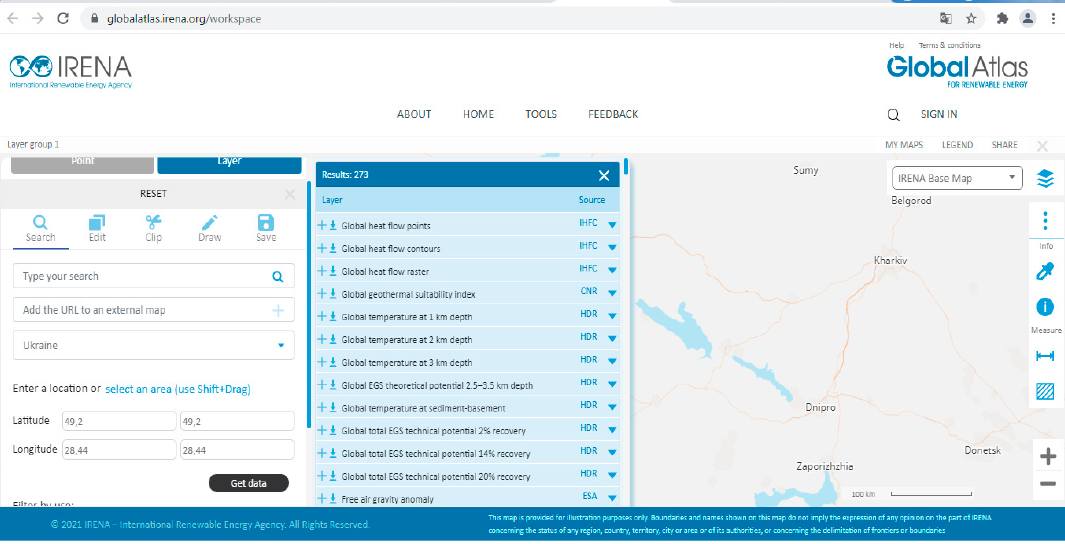
Figure 5. Selection of renewable energy characteristics in the Global Atlas program from IRENA for any area with coordinates in Ukraine (reproduction of graphic material from [30]).